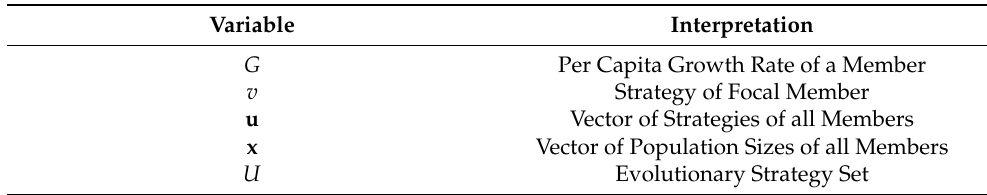
Table 1. Core Components of the G Function Framework.